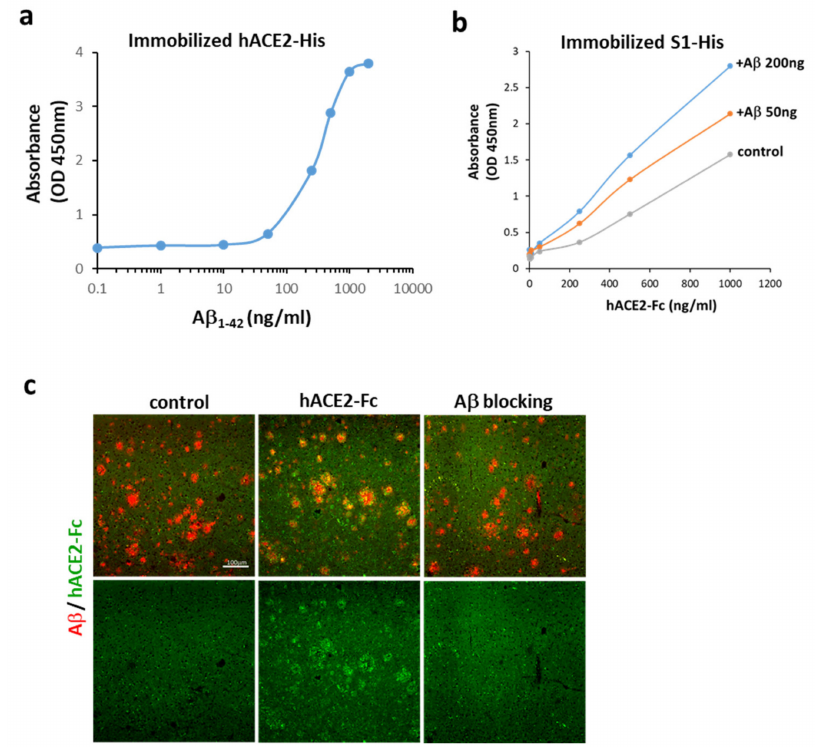
Figure 2. Interactions between A β 1-42 and ACE2. ( a ) A β 1-42 bound to immobilized hACE2-His (the estimated EC 50 is 274–363 ng/mL), suggesting an apparent interaction between A β 1-42 and hACE2. ( b ) ACE2-Fc bound to immobilized S1 of SARS-CoV-2 in the absence of A β 1-42 (control), and this binding was increased by pre-incubation of immobilized S1 of SARS-CoV-2 with A β 1-42 at 50 and 200 ng, whose binding potency was compared by OD. ( c ) As shown by confocal microscopy, exogenous hACE2-Fc (green) co-localized with A β plaques (red) in the brain tissue sections of APP/PS1 mice (vehicle shown in left panels vs. hACE-Fc in middle panels). Pre-incubation of hACE- Fc with A β 1-42 (right panel) completely blocked hACE2-Fc/A β plaque interaction (as indicated by A β blocking). Scale bar: 100 µ m. Data of the binding assay are presented as mean values from two independent